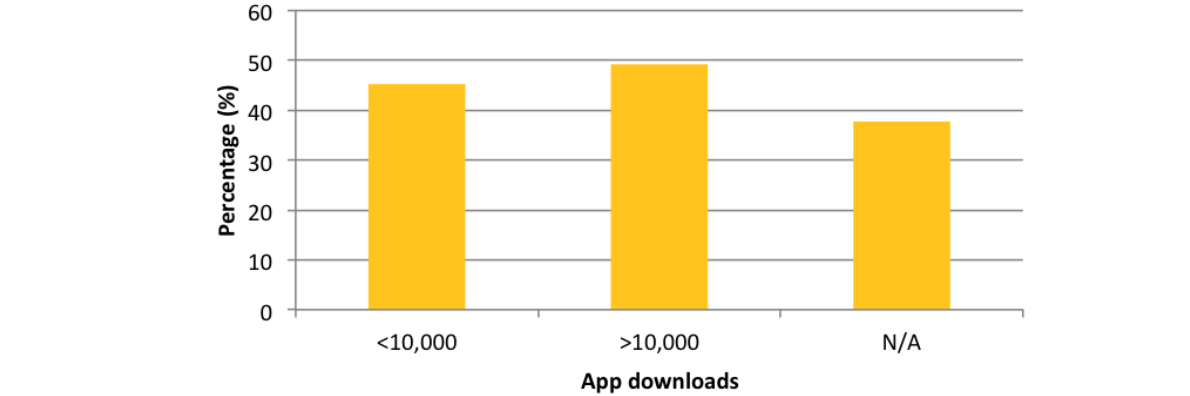
Figure 5. Chart comparing behavioral function percentage according to downloads.